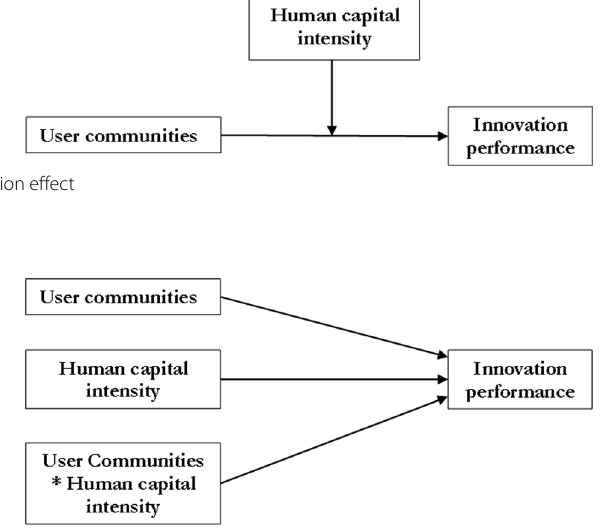
Fig. 4 Moderation effect empirically